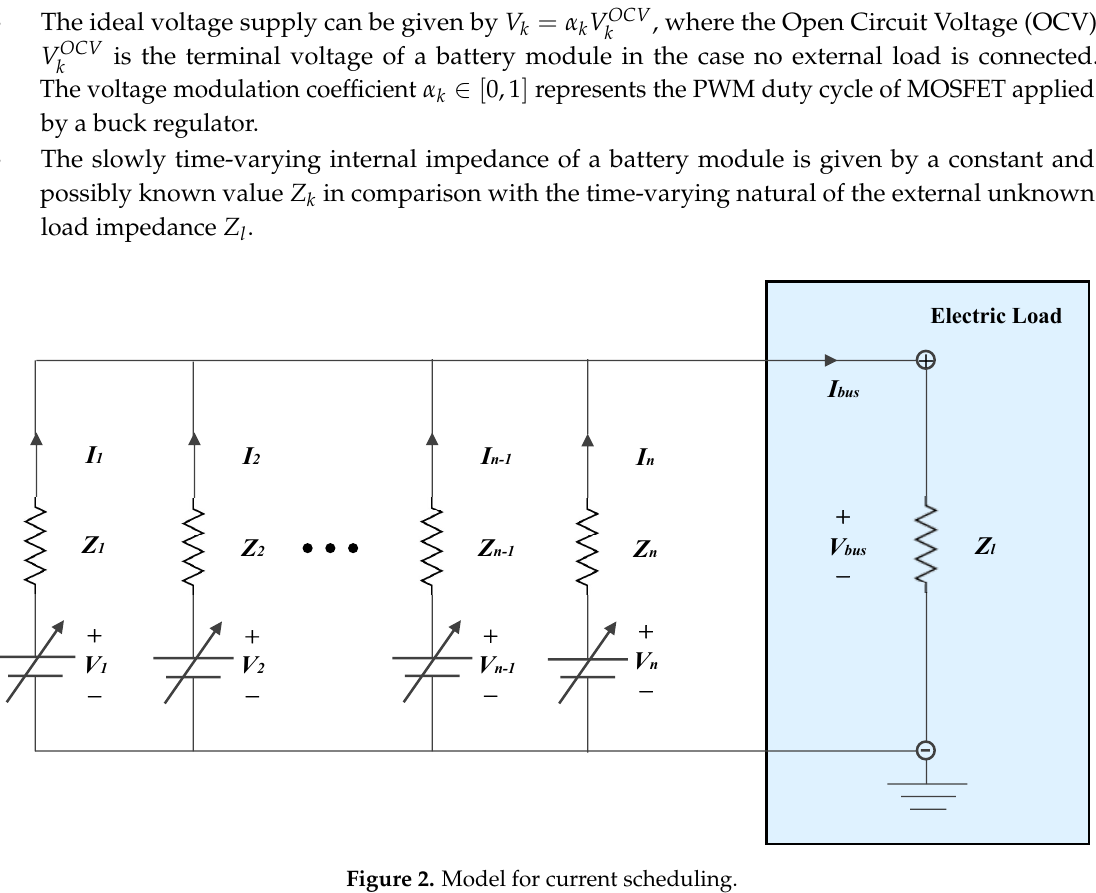
Figure 2. Model for current